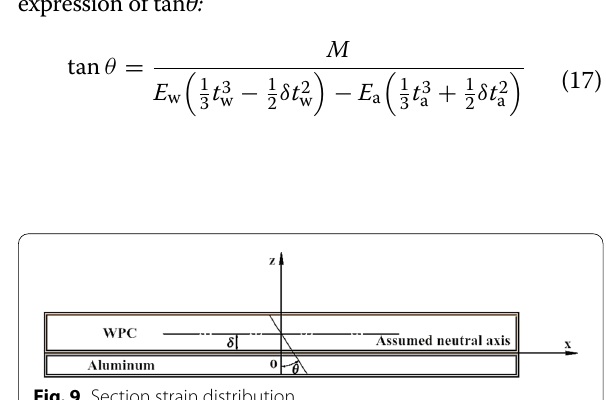
Fig. 9 Section strain